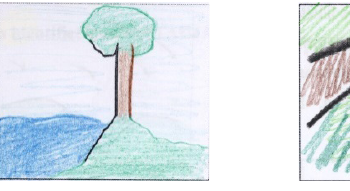
Figure 30. The creative task: interpretation of Fragment 5 – plants (source: testingmom.com, 2020) One Latvian student and Belarusian students interpreted not separate plants but a whole landscape: “a park”, “[...] see, tree and meadow”, “a landscape” (Figure 31). The research participants from Belarus interpreted the given fragment as a flower or a branch (Figure 30).